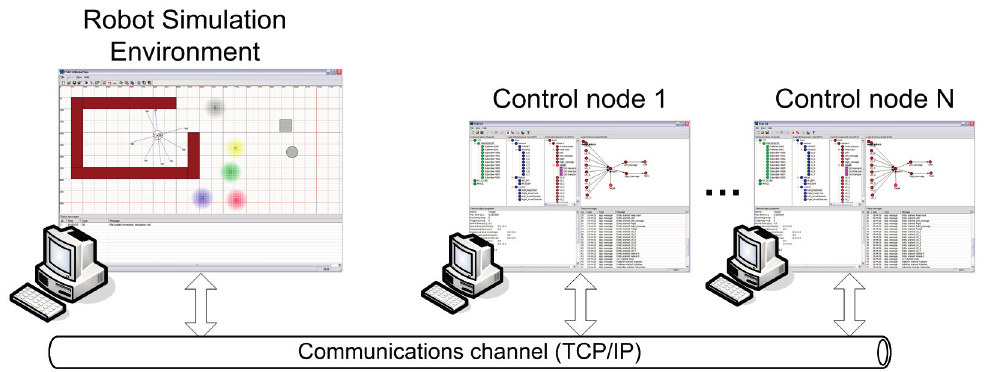
Figure 17. Experimental environment used to test the FSACtrl